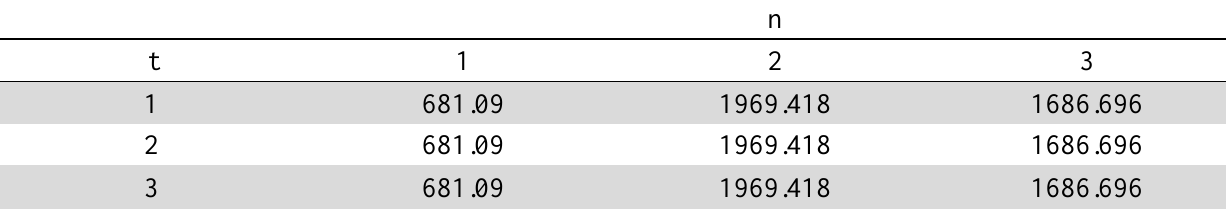
The resuls of the optimal